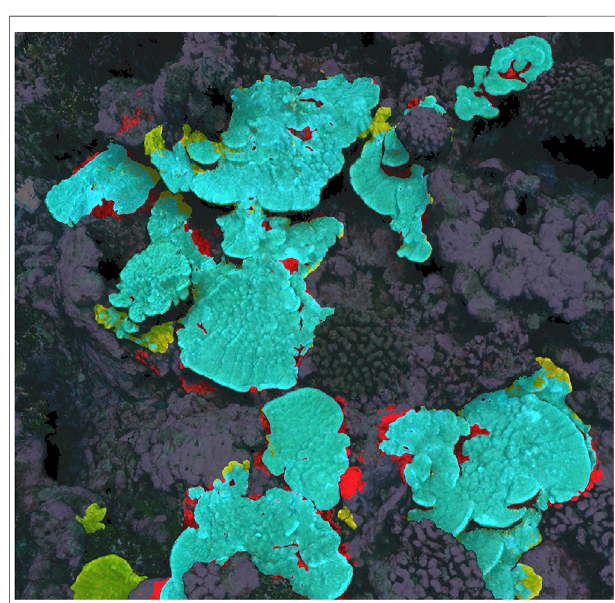
FIGURE 3 | Example of 3D neural network prediction (correct predictions are highlighted blue, false positive predictions are red, and false negative are yellow), corresponding to the same area as Figures 1 , 2